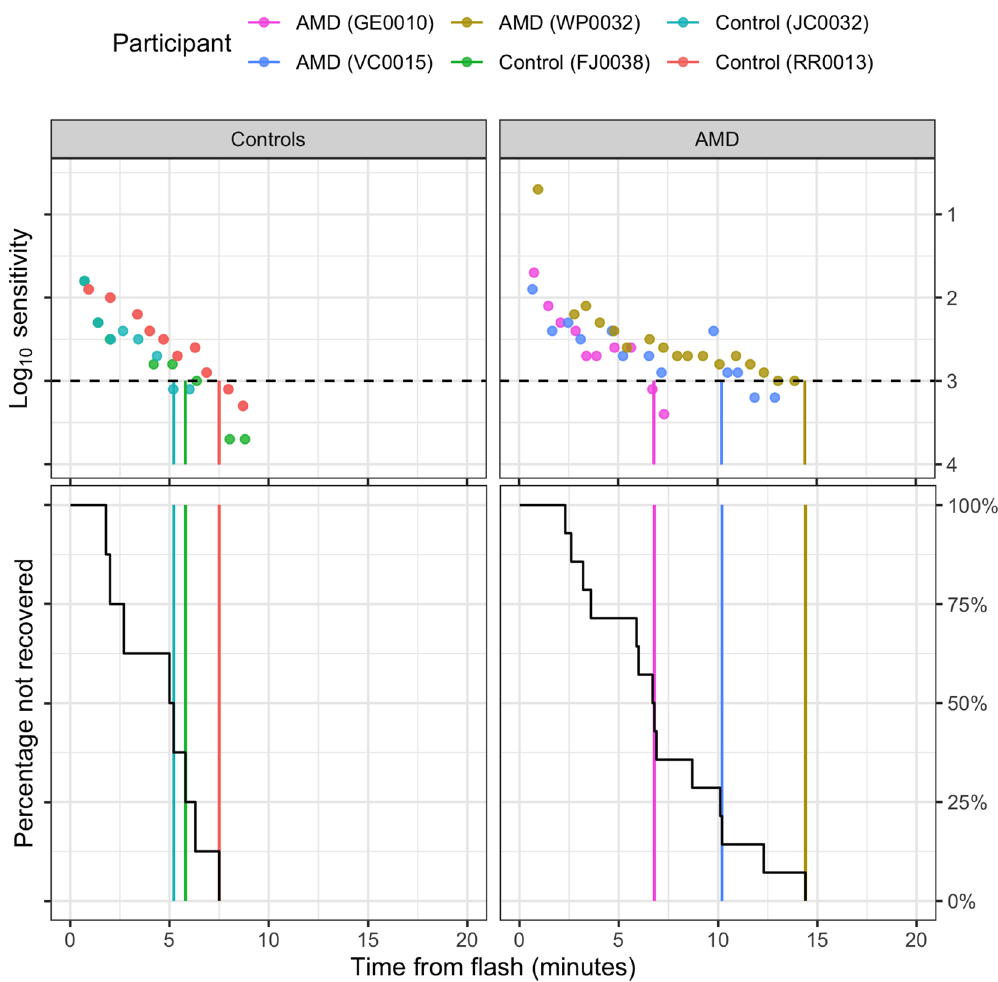
Figure 3. The change in Log 10 sensitivity for three control subjects and three patients with AMD is plotted in the top panel (filled dots) with the corresponding Rod Intercept Time values (vertical strokes) provided by the device. The horizontal dashed line represents the 3 log-step change in sensitivity used by the device to define the event (recovery from bleaching). The RIT time for each recovery “event” is used to build the survival curves (bottom panels). In this case, the vertical coloured lines also identify the same RIT values recorded for the curves plotted in the top panels. Notice how each vertical line corresponds to a downward step change in the survival curve (in black). The same process is applied for all RIT values in the dataset to calculate the other step changes that make up the rest of the survival curve. A marker demonstrating the cut off time has been added. Figure generated using the ggplot2 package 32